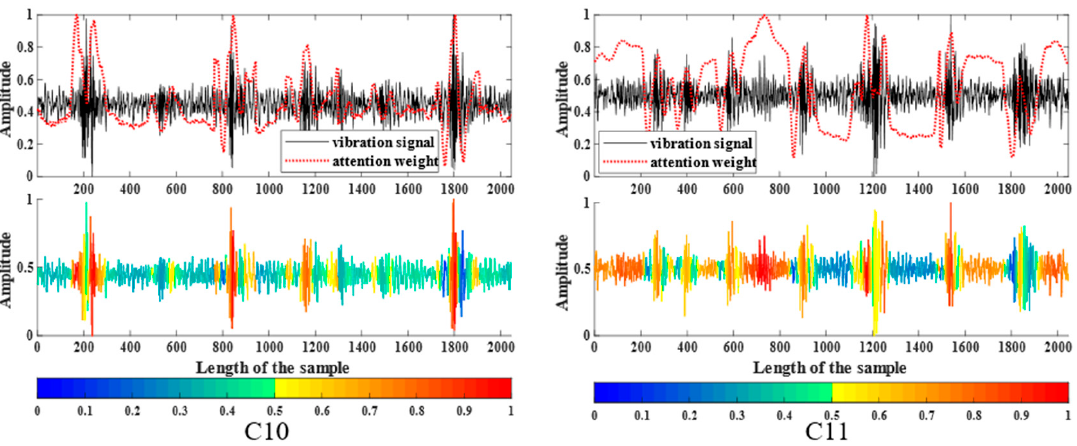
Figure 11. Visualization of attention weights for compound faults. C10, C11 correspond to the Pattern Label in Table 2.